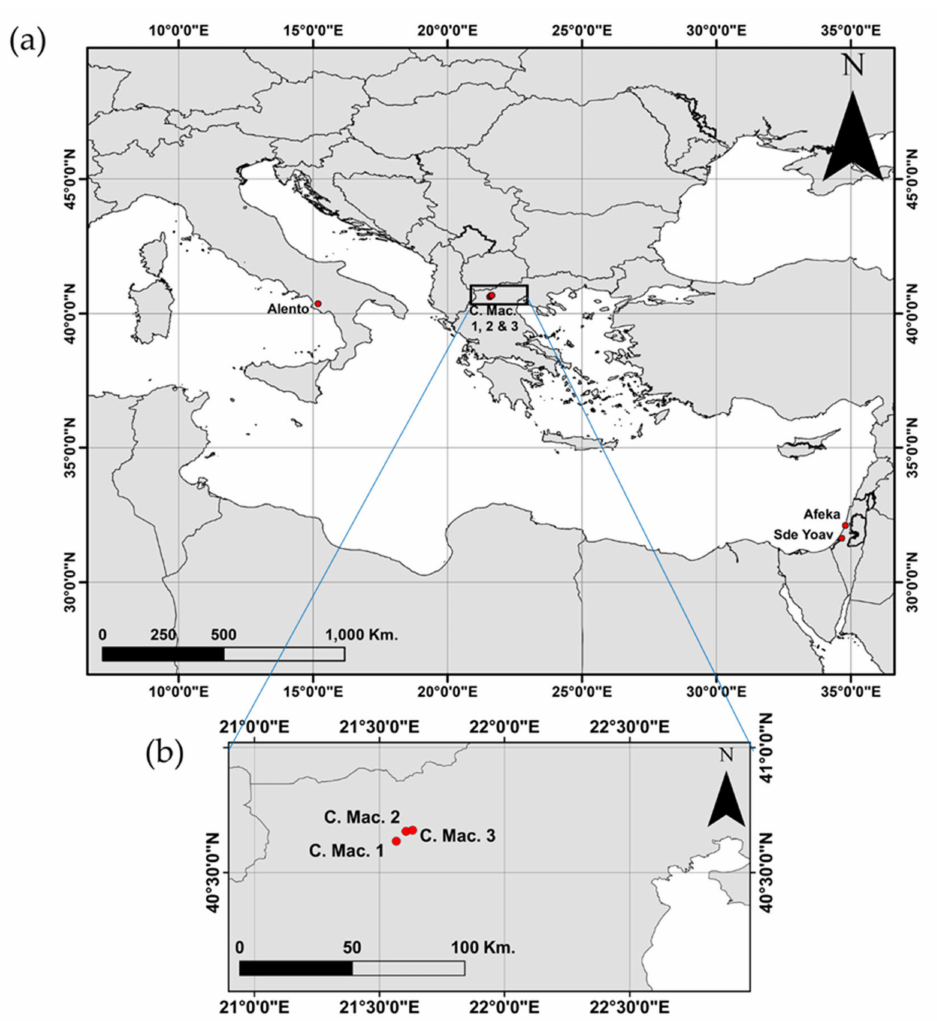
Figure 1. ( a ) Mediterranean basin and the locations of the fields from which the samples were collected. ( b ) Zoomed in view of the central locations of the fields in